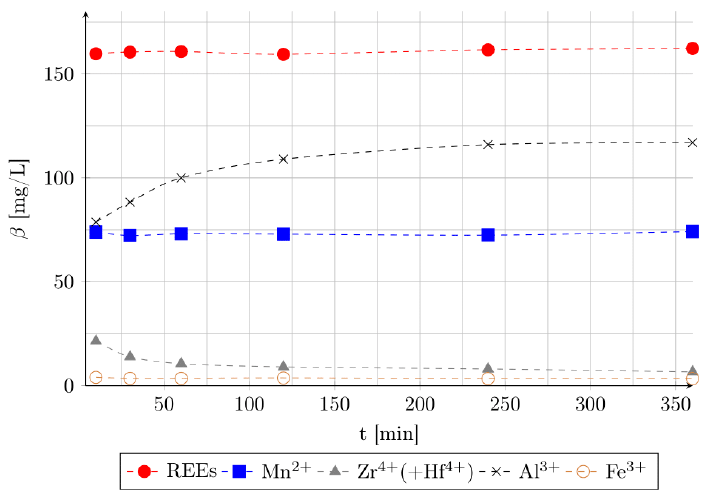
Figure 7. Effect of time on leaching of REEs, Zr 4+ (+Hf 4+ ), Mn 2+ , Nb 5+ , Al 3+ , Fe 3+ ( (cid:1866) H + /(cid:1865) conc. = 15 mmol/g; T G = 750 °C; t G = 2 h; ϱ PD,L = 25 kg/m 3 ; T L = 20 °C; t L = 24 h; r R,L = 300 rpm).